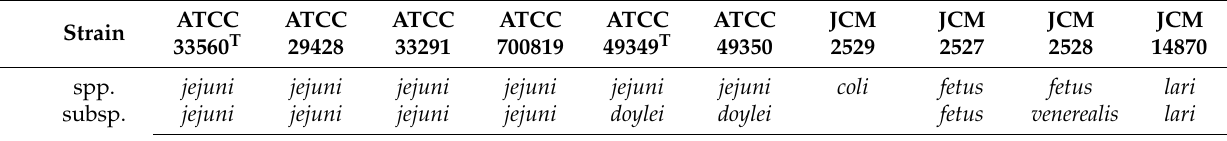
Table 2. Theoretical masses of biomarker peaks in S10-spc-alpha operon and their detection.